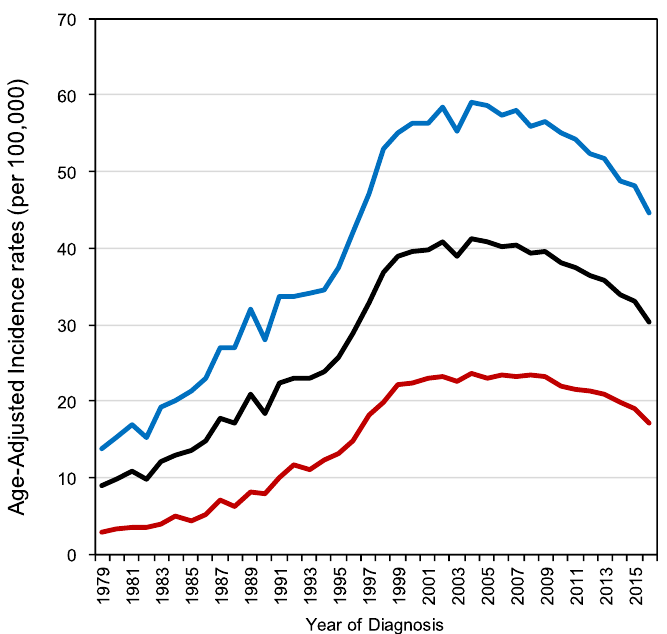
Figure 1. Age-adjusted incidence of hepatocellular carcinoma (HCC) (per 100,000) from 1979 to 2015. Black line: both genders; blue line: male gender; red line: female gender (national reimbursement program for the treatment of chronic viral hepatitis launched in 2003; data released by the Ministry of Health and Welfare, Taiwan).